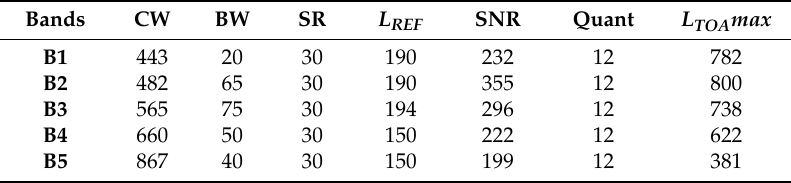
OLI/Landsat 8sensor configurations used as the input for simulation. CW is the central wavelength (nm), BW is the band width (nm), SR is the Spatial Resolution (m), L REF (W · m − 2 · sr − 1 · µ m − 1 ) is the radiance in which the SNR was calculated, Quant is the